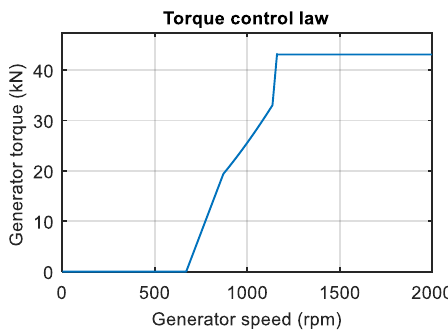
Figure 1. Theoretical law of torque control based on the MPPT algorithm. A constant wind speed with the value of the nominal wind speed is considered.